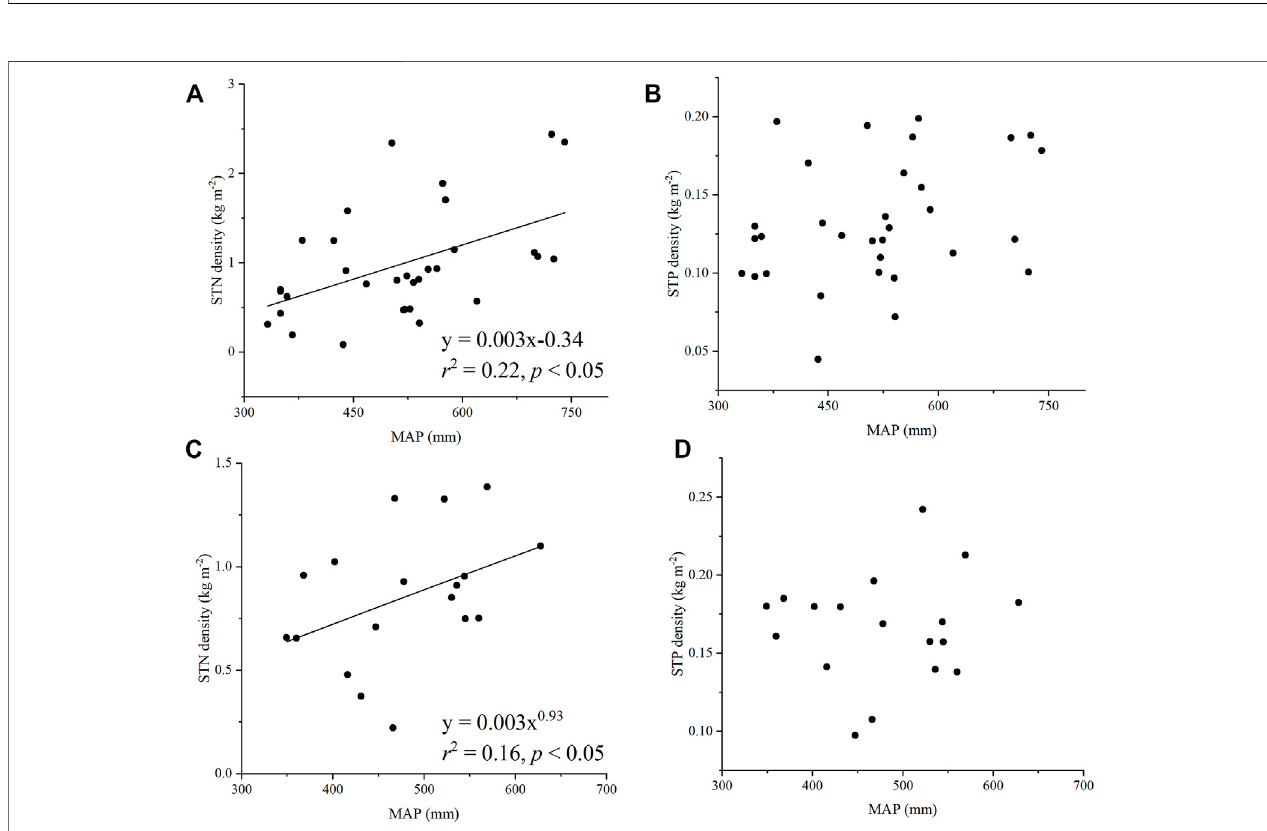
FIGURE3| RelationshipsofSTNdensity (A,C) andSTPdensity (B,D) withMAPinalpinewetlands (A,B) andalpinemeadow (C,D) .STNdensity,soiltotalnitrogen density; STP density, soil total phosphorus density; MAP, mean annual precipitation.